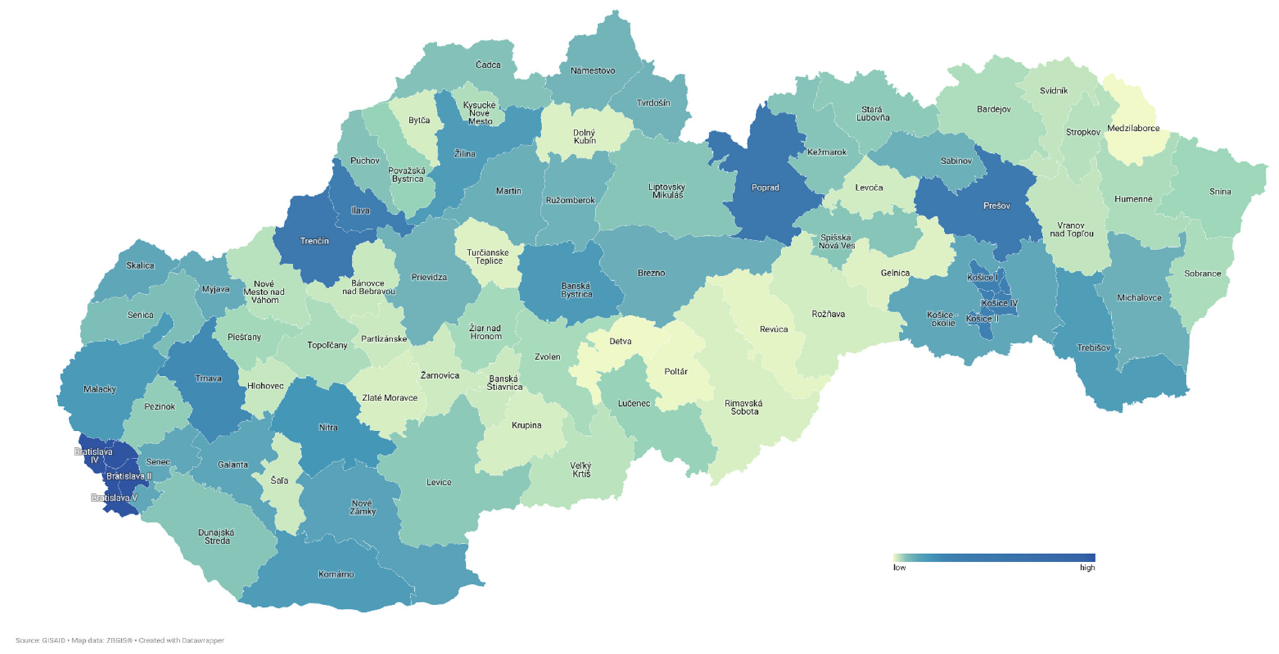
Figure 1. Map of quantity and origin of SARS-CoV-2 samples in SR. Heterogeneity of sequenced samples in districts range from 21 from Medzilaborce up to 3894 in Bratislava (created with datawrapper.de). List of all districts with exact numbers of sequenced samples are in the Supplementary data Table S1.